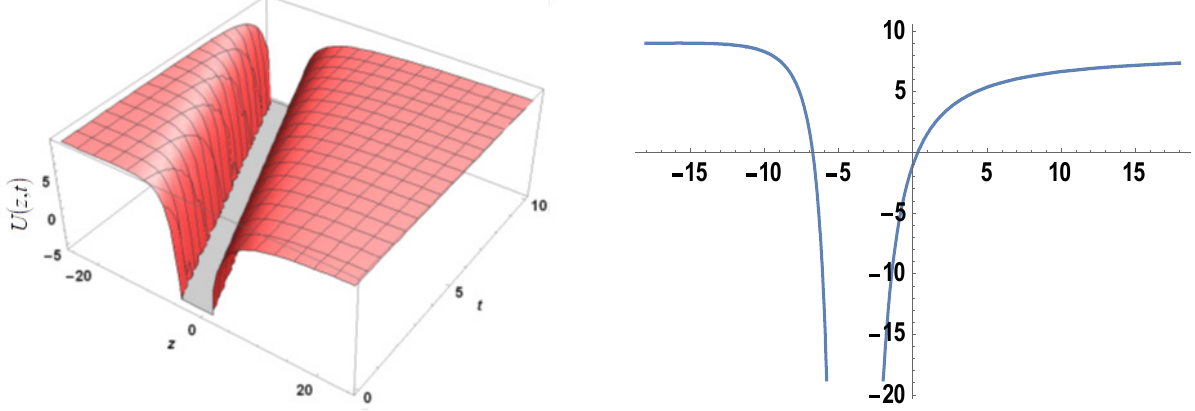
Figure 4. The 3D and 2D plots of Equation (54) for various values of parameters.